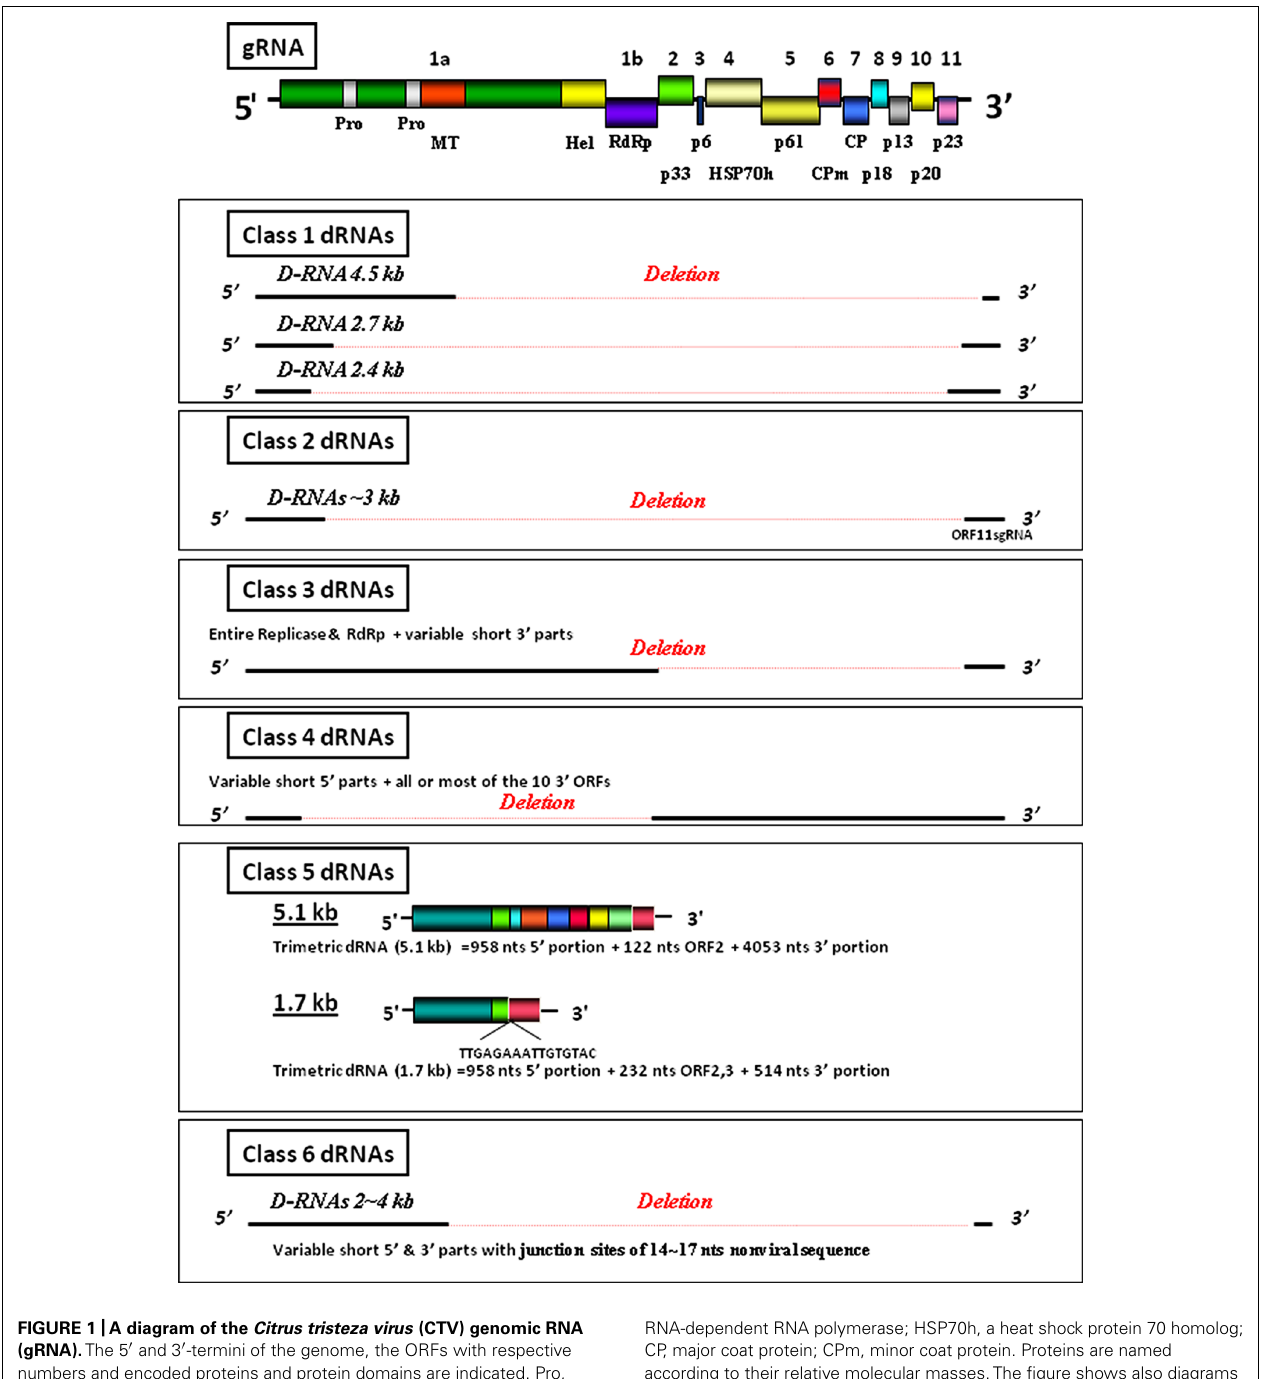
FIGURE 1 |A diagram of the Citrus tristeza virus (CTV) genomic RNA (gRNA). The 5 (cid:3) and 3 (cid:3) -termini of the genome, the ORFs with respective numbers and encoded proteins and protein domains are indicated. Pro, papain-like protease; MT, methyltransferase; Hel, RNA helicase; RdRp,